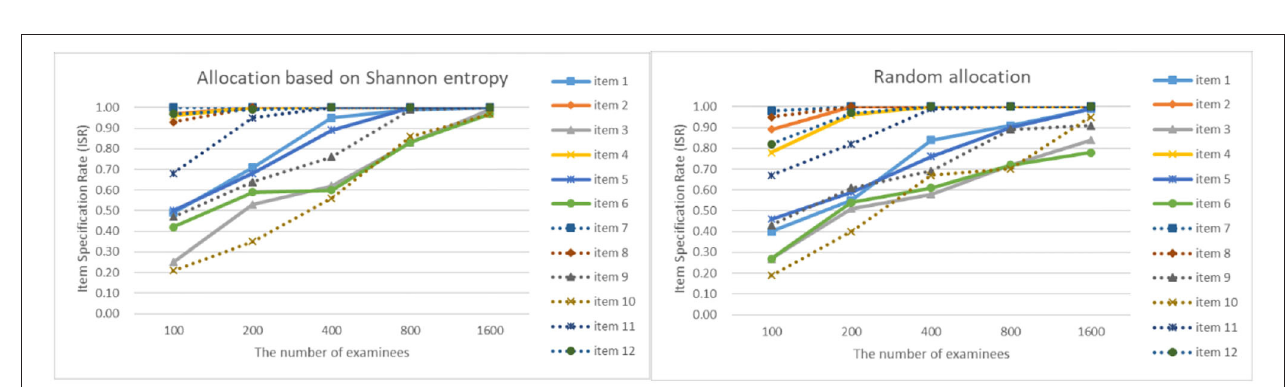
FIGURE 6 | The ISR for two strategies when the initial value of the item parameter is 0.25.